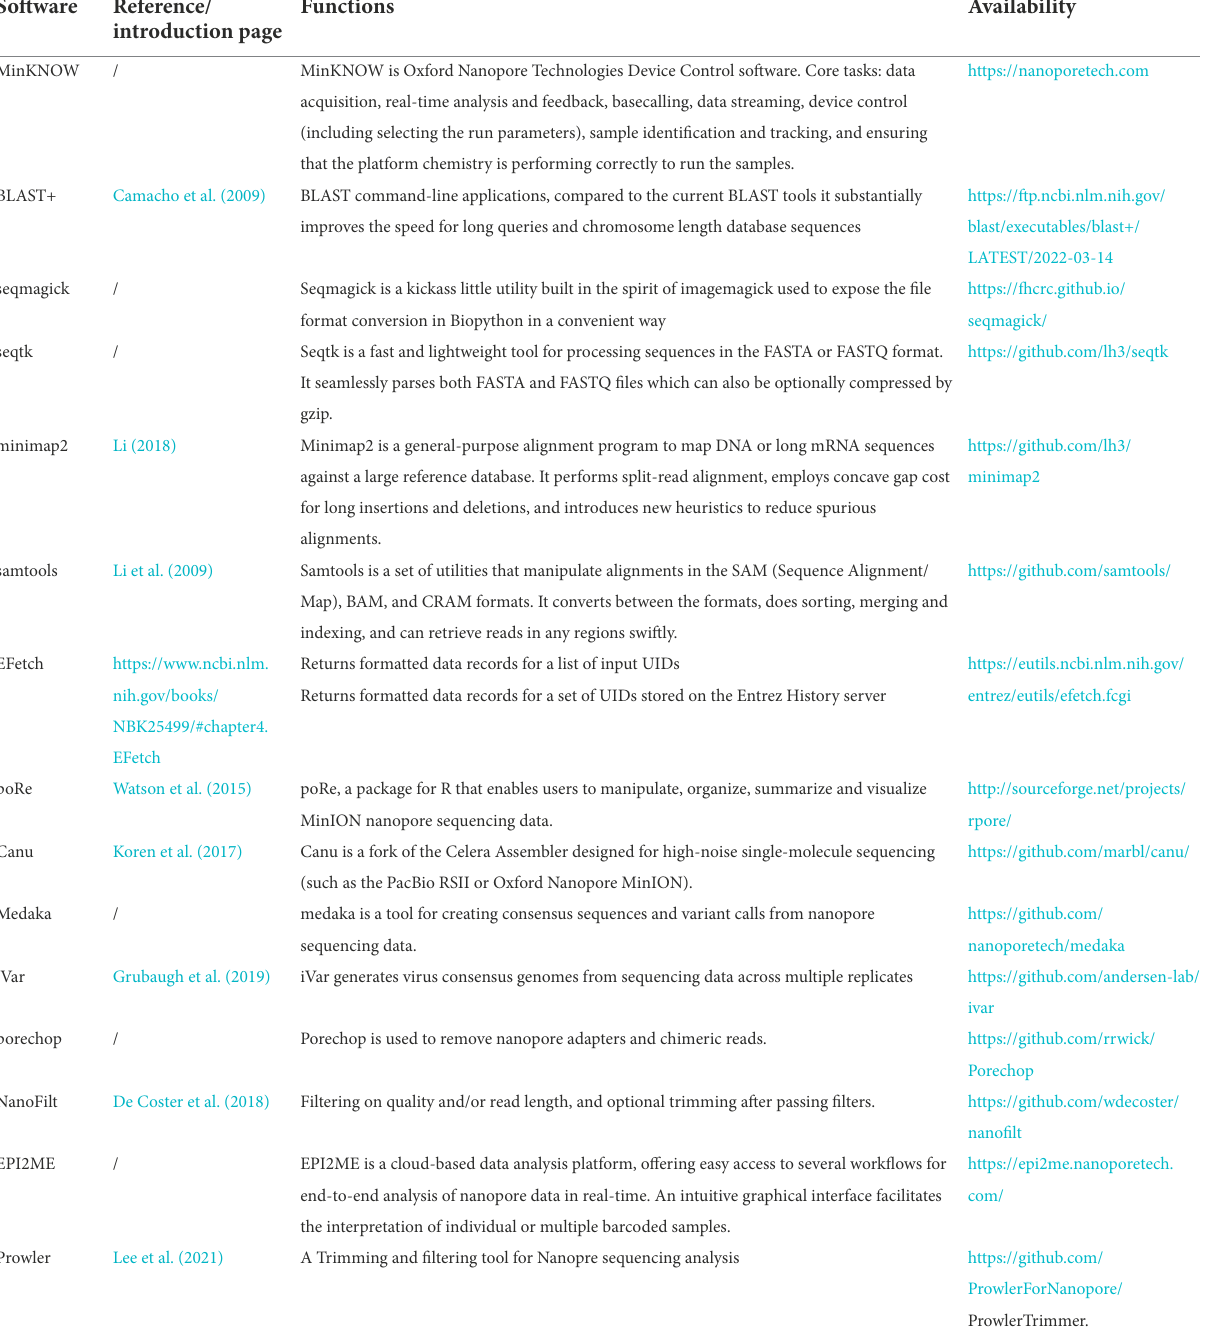
TABLE 2 Bioinformatics tools for the identification of plant viruses using nanopore sequencing.